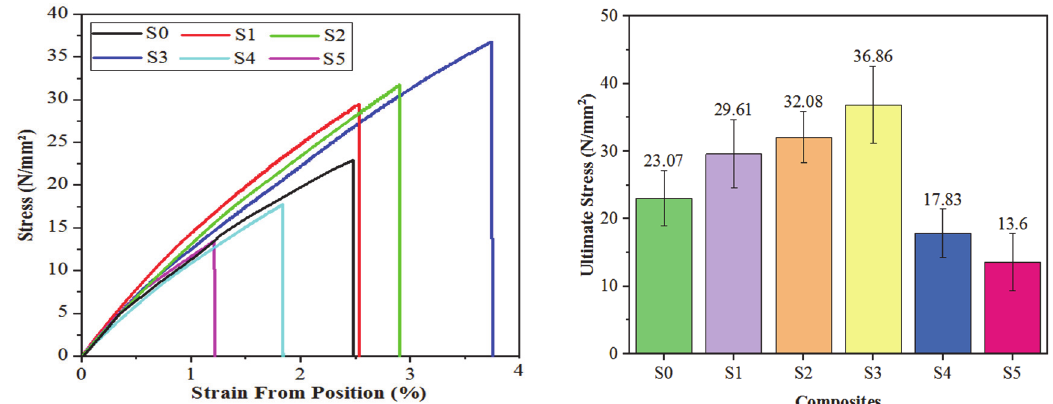
Figure 5 : Stress-strain curves (left) and Tensile strength (Right) of all composites